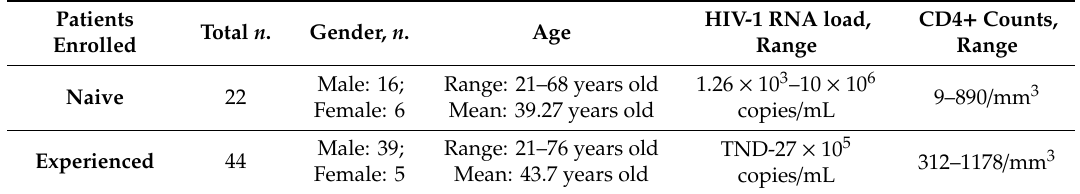
Table 1. Demographics and clinical features of HIV-1-positive patients at